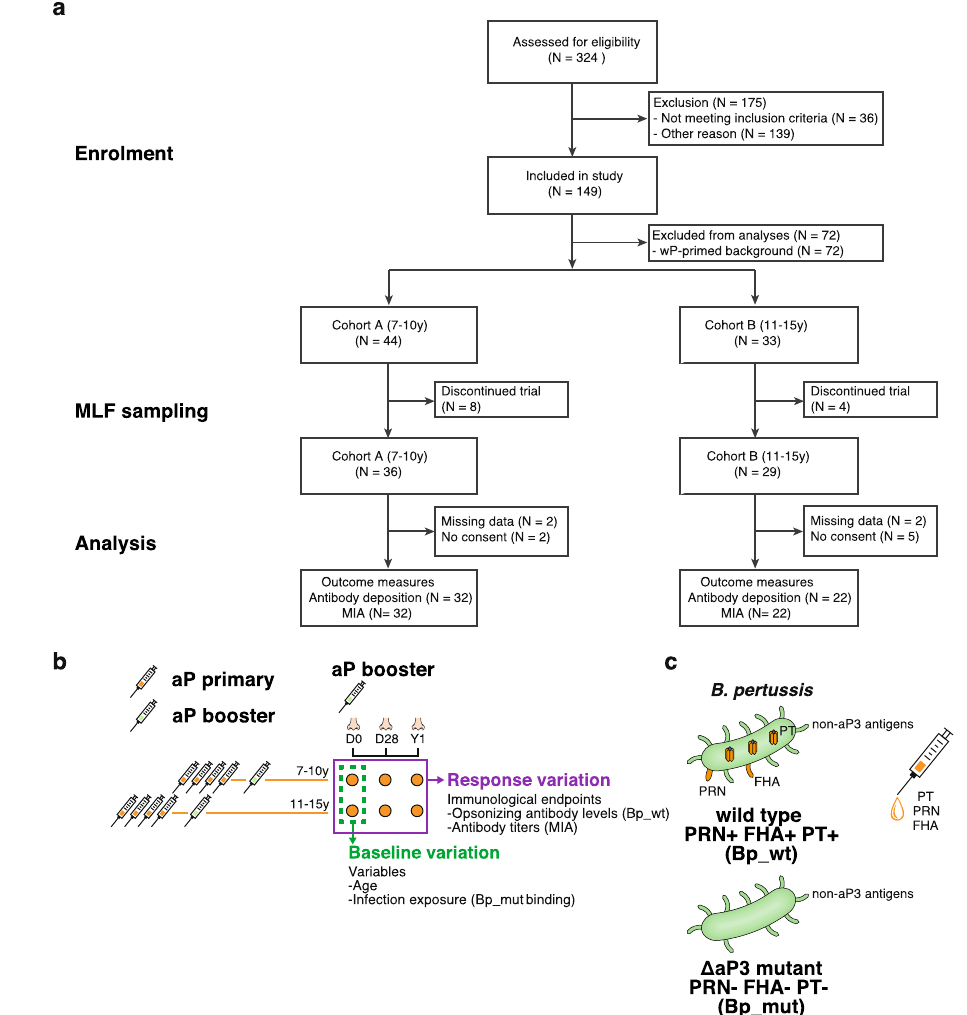
Fig. 1 | Flow diagram of the booster vaccination study and study procedures. a Flow diagram describing the recruitment of volunteers, sample sizes, and out- come measures. b Overview of the study design, immunological endpoints and framework for analyzing factors contributing to variation in immunological end- points.Nasalmucosallining fl uid(MLF) wasobtainedatbaseline (D0),and 28days (D28) and one year (Y1) after vaccination with a dose of the tetanus-diphtheria- acellular pertussis-inactivated polio virus (Tdap-IPV) combination